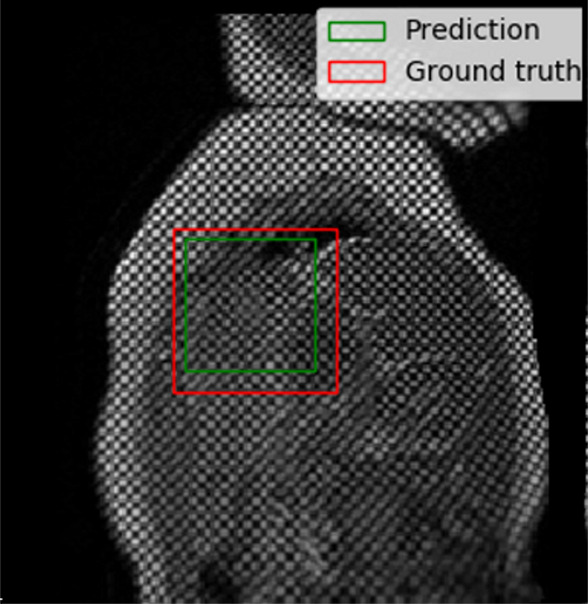
Example results from the localization network. (a) Intersection over union (IoU) of 53% and (b) IoU of 63% are the worst prediction results within the test set. (c, d) Typical prediction results. (e) Histogram shows the distribution of accuracy (IoU) throughout the test set.